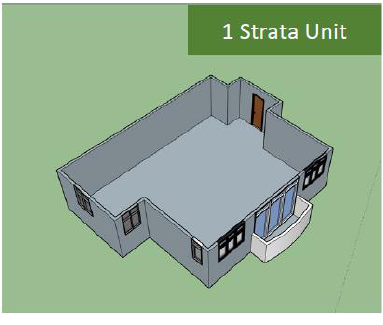
Figure 2. 3D model of a strata unit